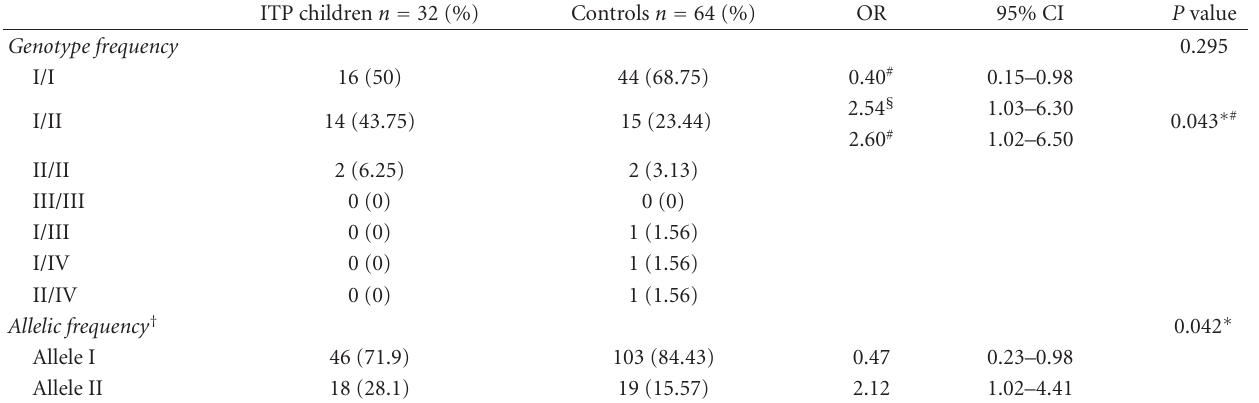
Table 3: Distribution of allele and genotype frequencies of IL-1 Ra VNTR polymorphism in children with ITP and